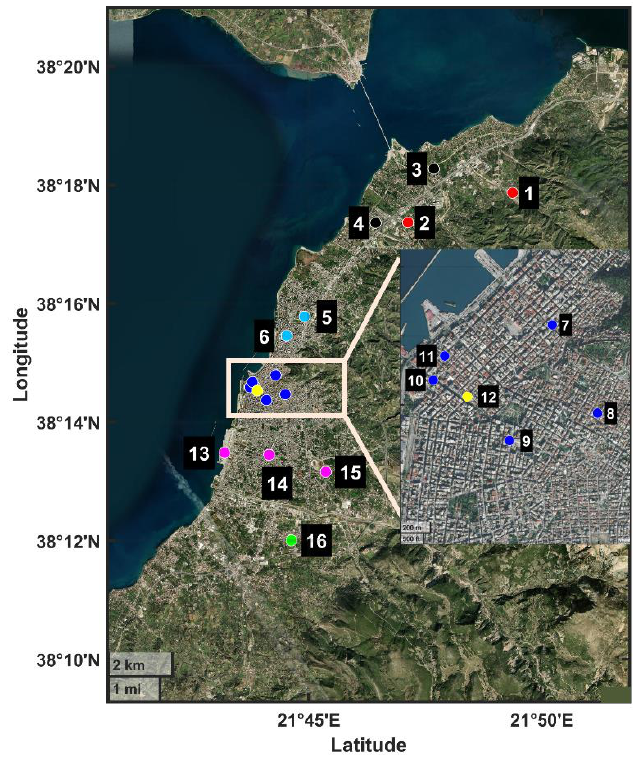
Figure 1. Spatial distribution of the measurement sites across the city of Patras. The inset shows an enlarged view of the city center where several measurement sites are located. The colored dots represent the type of each site: (a) background (red); (b) suburban north (black); (c) urban north (cyan); (d) city center (blue); (e) high-restaurant-density area in city center (yellow); (f) urban south (magenta); (g) suburban south (green). The numbers correspond to the stations of the